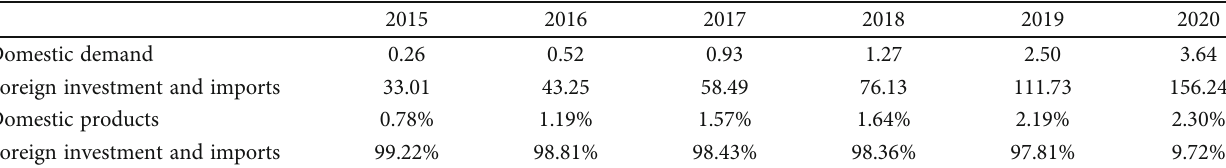
Table 2: China ’ s ultrasound contrast agent market segmentation product demand quantity.